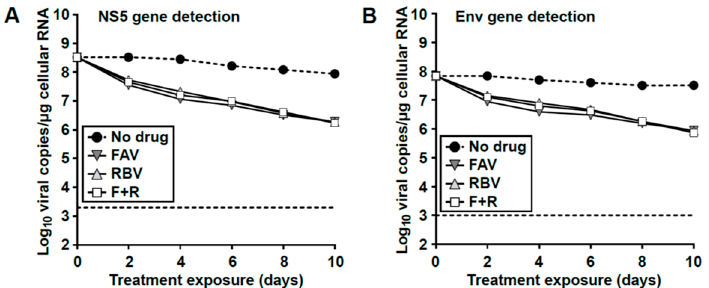
Figure 7. Intracellular viral RNA detected in S p39 persistently-infected cells treated with antiviral drugs. These RNA extracts were obtained from the experiment represented in Figure 5A. Viral RNA levels detected in whole cell monolayer extracts after treatment with FAV, RBV, or a combination of both drugs (F + R) at a concentration of 2000 µ M for each drug. For each treatment regime, 6 independent wells were seeded ( n = 6) and samples were collected at di ff erent time points ( n = 1). Quantitative PCR (qPCR) methods, based on the detection of NS5- ( A ) and Env-coding regions ( B ) are used. A dashed line represents the limit of detection.